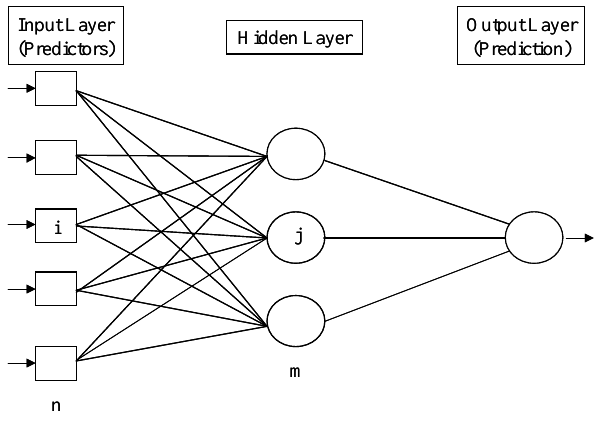
Fig. 2. An idealized feed-forward ANN characterized by n input nodes (the predictors or independent variables), m hidden nodes and one output node (the prediction or dependent